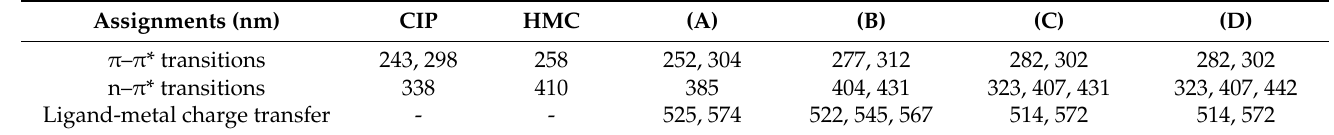
Table 3. UV–Vis spectra for CIP, HMC, and their Zr(IV) complexes (A) , (B) , (C) , and (D) .